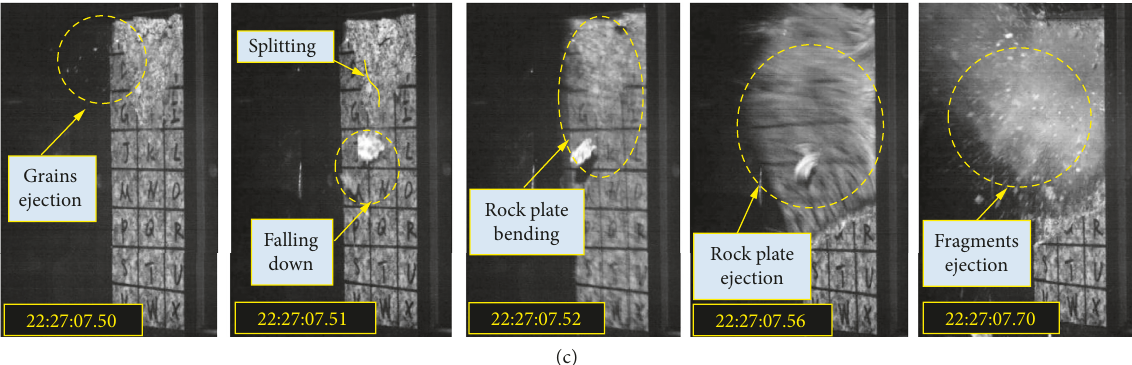
Figure 19: The rockburst process of the tested specimen under different support failure rates (the numbers at bottom-left corner of the pictures indicate the time in h:m:s.ms): (a) v